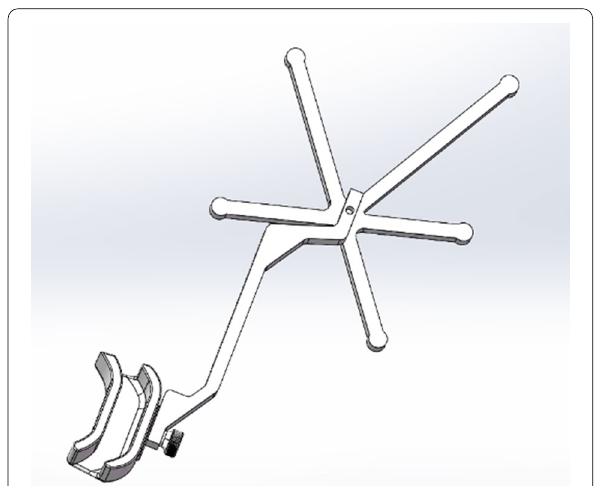
Figure 4 Illusion of the irregular pentagonal retro-reflective marker